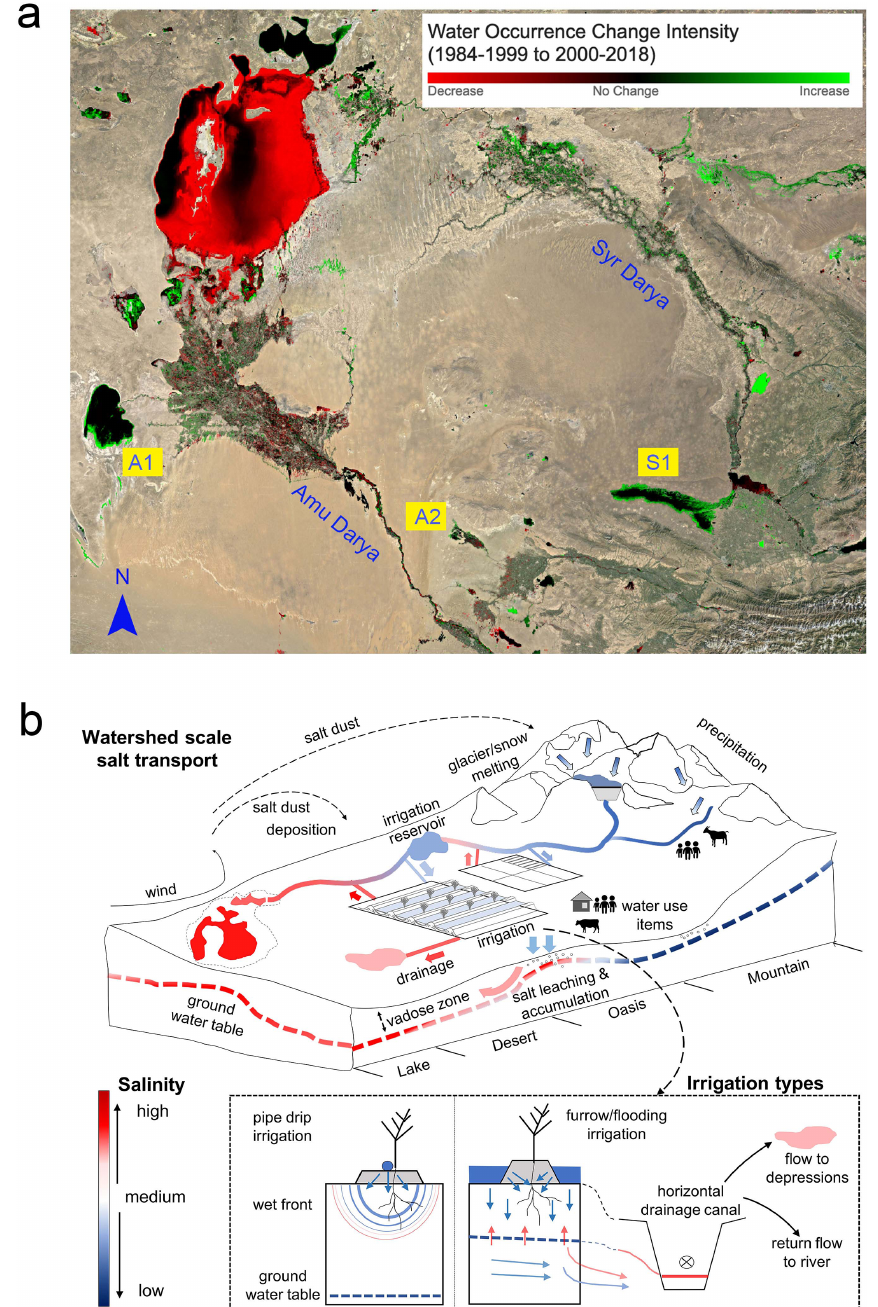
Figure 11. The long-term inefficiency and risk of the irrigation-drainage system. (a) Changes in the surface water occurrence in the Aral Sea basin. The data and information originate from the Global Water Surface Explorer (https://global-surface-water.appspot.com/, last access: 1 October 2020) (Pekel et al., 2016). S1, A1 and A2 are examples of expanded depressions, which collected the drainage and surplus water. S1 is the Aydar Lake in the Syr Darya River basin. In the Amu Darya River basin, A1 represents the Sarykamysh Lake and A2 illustrates a drainage depression of the Bukhara irrigation district. (b) Salinity concentration in the irrigation-drainage system of the Aral Sea basin. The upper part stands for the salt transport and concentration at the river basin scale. The lower part shows the positive effect of drip irrigation compared with flood irrigation on reducing the drainage water and lowering the groundwater level to reduce the secondary